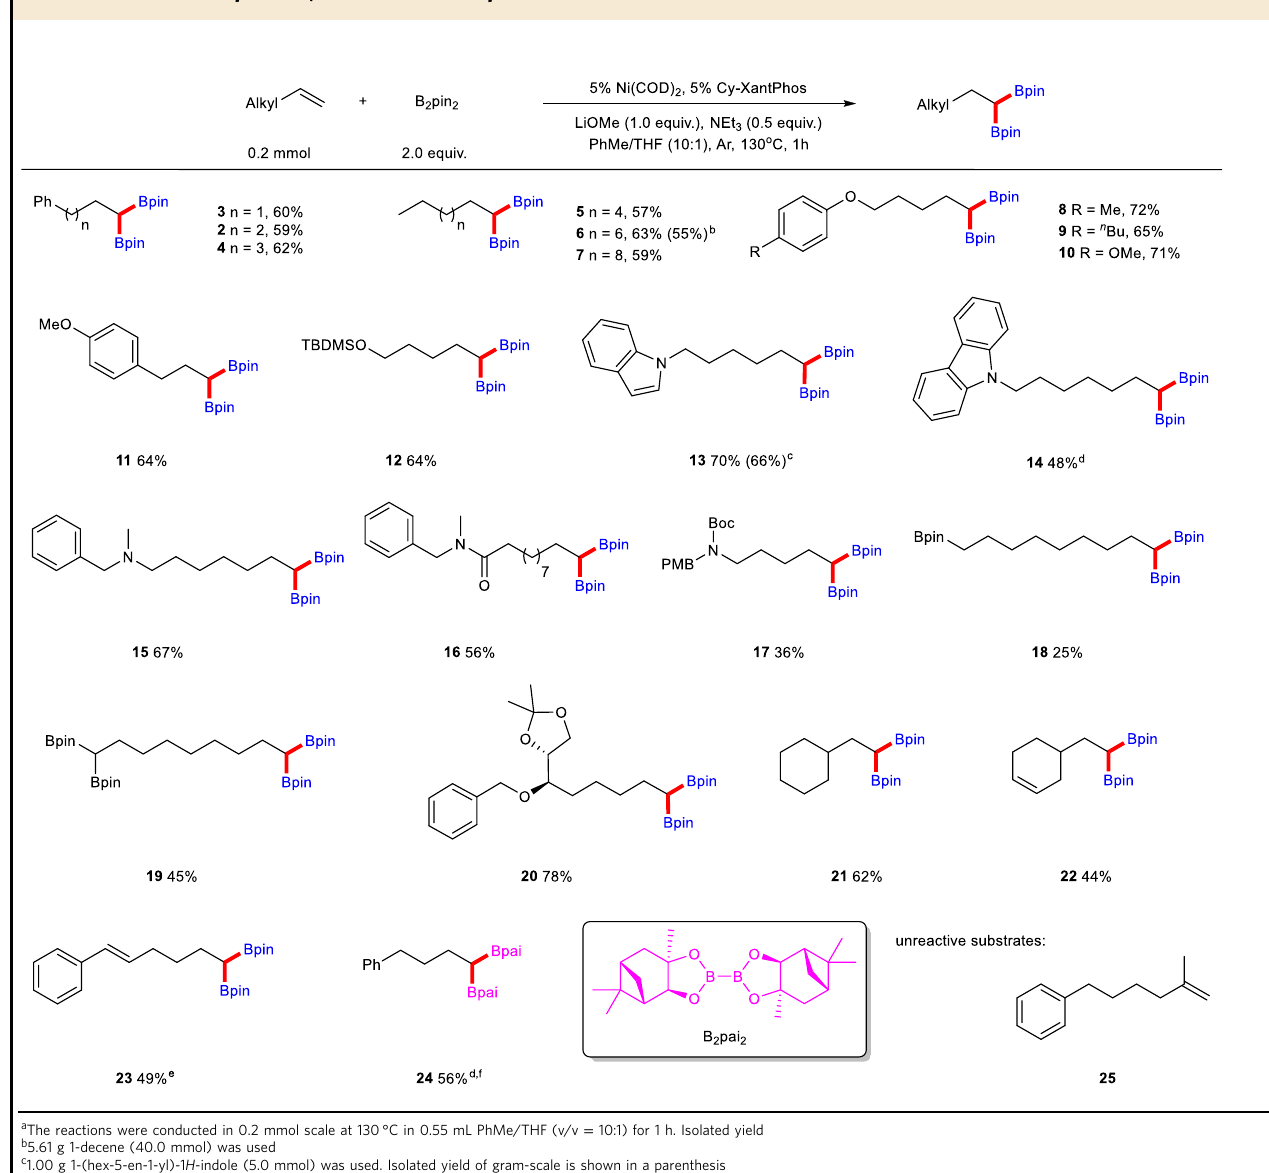
Table 2 Substrate scope for 1,1-diboration of aliphatic alkenes